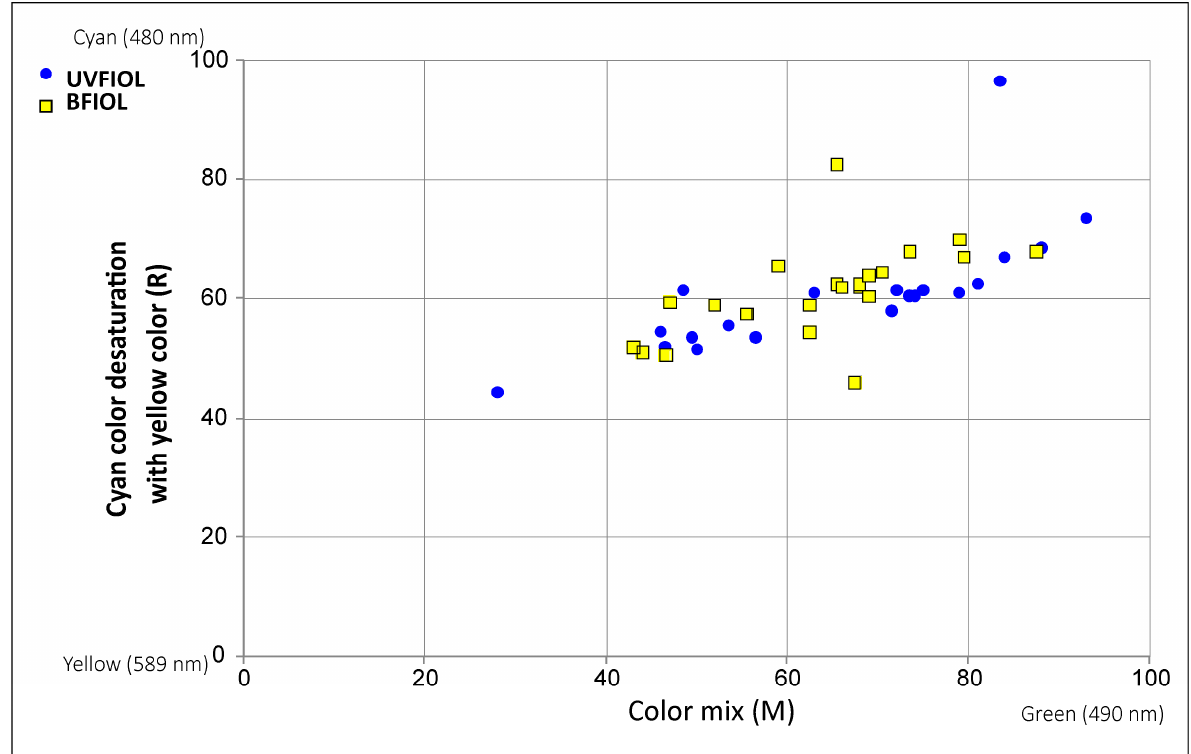
Figure 2. Results from anomaloscope testing. UVIOL—UV blocking intraocular lens; BFIOL—Blue light-filtering intraocular lens. We could notice a slight shift of the BFIOL group towards green and yellow color. However, this shift was not statistically significant ( p > 0.05).